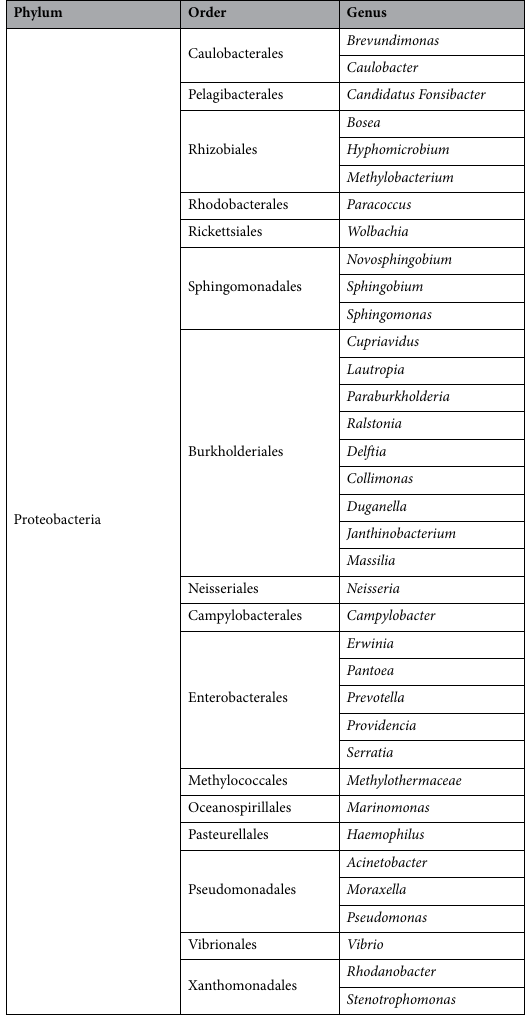
Table 1. Lists of bacterial taxa classified at phylum, order, and genus